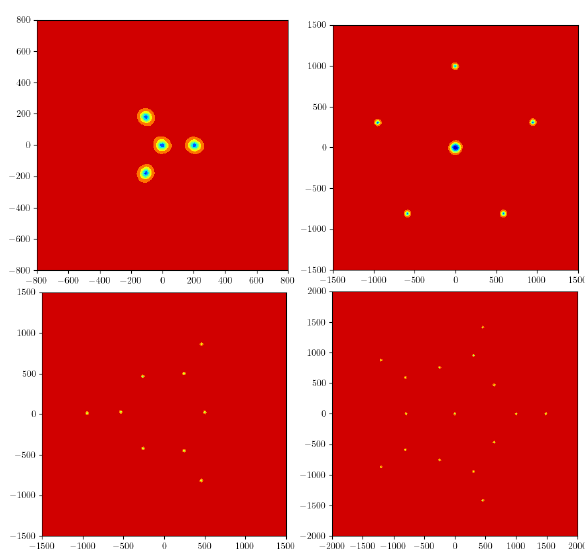
Figure 1. Transverse intensity distributions in the ( x ,y ) plane of several vortex structures that remain unaltered during propaga- tion. See the text for the description of each configuration.